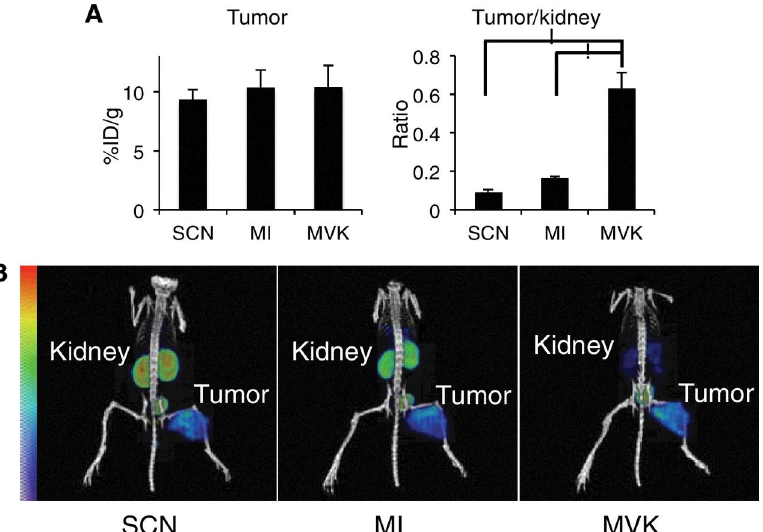
Figure 5. Tumor and kidney accumulation of radioactivity in mice after 3 h injection of 67 Ga-labeled Fab fragments. ( A ) Radioactivity in tumor and corresponding tumor/kidney ratios after injection of 67 Ga-NOTA-Fab (SCN), 67 Ga-NOTA-MI-Fab (MI), and 67 Ga-NOTA-MVK-Fab (MVK) in nude mice bearing SY tumors. Because of much lower renal radioactivity, 67 Ga-NOTA-MVK-Fab yielded significantly higher tumor/kidney ratios than 67 Ga-NOTA-MI-Fab and 67 Ga-NOTA-Fab. ( B ) SPECT/CT images of nude mice. 67 Ga-NOTA-MVK-Fab provided highest contrast tumor image. Reprinted with permission from ref. [63]. Copyright 2018 American Association for Cancer Research.